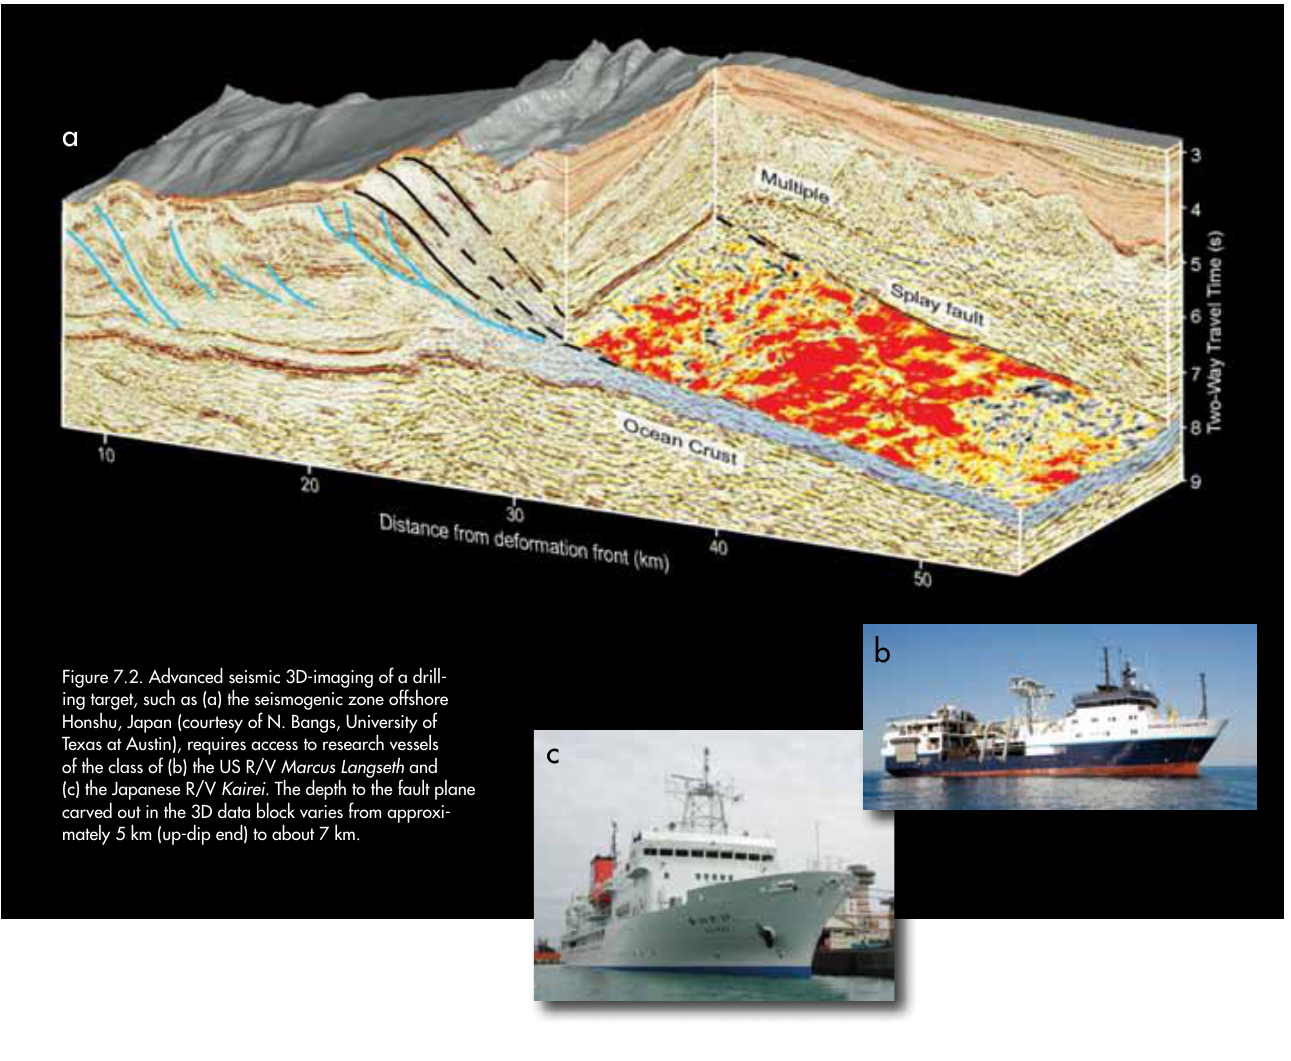
figure 7.2. advanced seismic 3d-imaging of a drill- ing target, such as (a) the seismogenic zone offshore honshu, Japan (courtesy of n. Bangs, University of Texas at austin), requires access to research vessels of the class of (b) the Us r/v Marcus Langseth and (c) the Japanese r/v kairei. The depth to the fault plane carved out in the 3d data block varies from approxi- mately 5 km (up-dip end) to about 7